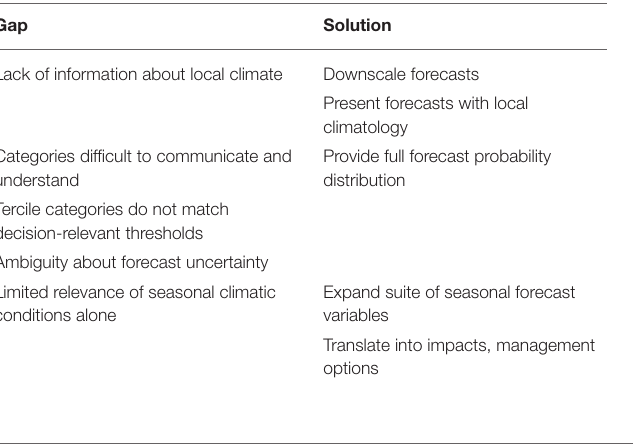
TABLE 2 | Suitability of different communication channels for climate service communication functions (***, well suited; **, moderately suitable; *, less suitable), based on the authors’ subjective preliminary assessment.